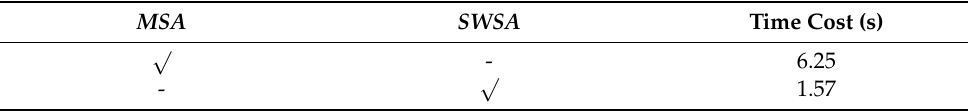
Table 7. Computational cost of different UIE